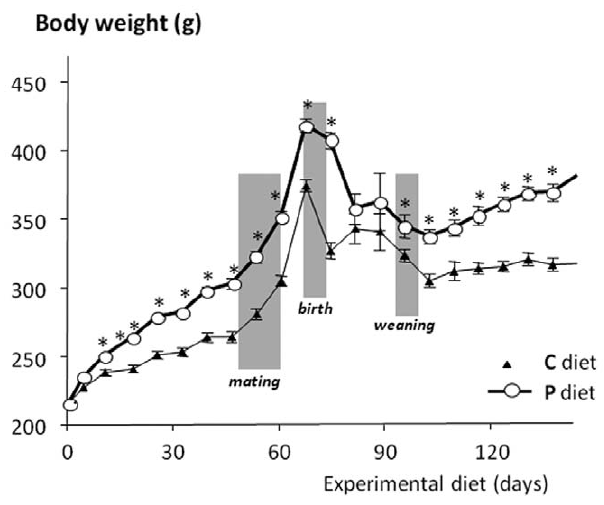
Figure 2. Evolution of the body weight of dams fed the control (C) diet (n=16) or highly palatable diet (P) (n=16) for 6 wk before mating, throughout gestation and lactation (28 days) and until the postweaning period (*p , 0.05).